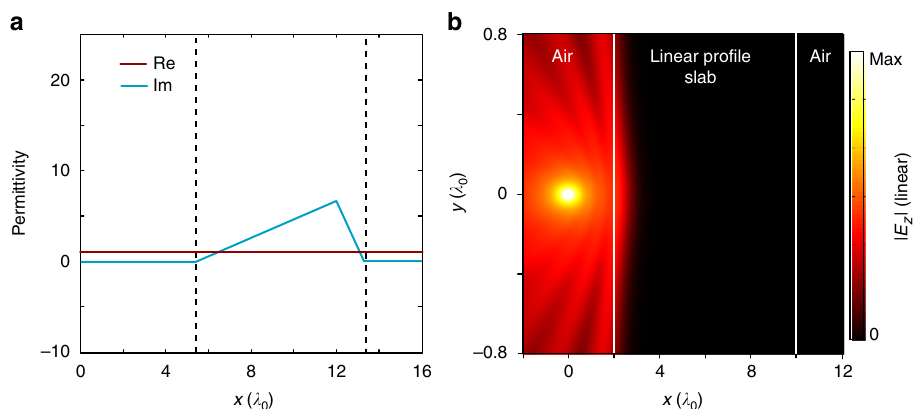
Fig. 9 Re fl ection of a linear pro fi le slab. a The linear permittivity pro fi le slab with the same thickness and variation range of the imaginary part of permittivity as those shown in Fig. 8b. The real part of the linear permittivity pro fi le is set as a constant value of 1, so that it can perfectly match the real part of the permittivity of air. The imaginary part is linearly increased from 0 (at the front edge located at x = 5.45 λ 0 ) to the maximum value of 6.7 at x = 12 λ 0 . Here both the maximum value and its location are the same as those in Fig. 8b. It is then linearly decreased from 6.7 to 0 at the back edge of the slab located at x = 13.45 λ 0 . This con fi guration is the best case for an absorbing slab with a linear permittivity pro fi le to obtain an optimal re fl ection performance. b The simulated wave re fl ection due to the linear pro fi le